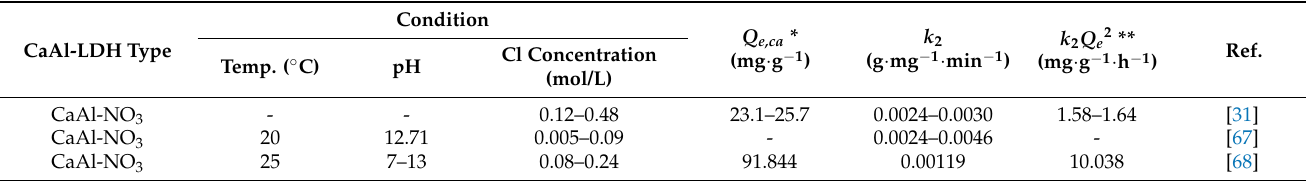
Table 2. Potential chloride removal rate of calcium aluminate-layered double hydroxides (CaAl-LDH) phases obtained by pseudo-second order kinetic model in previous studies [31,67,68].